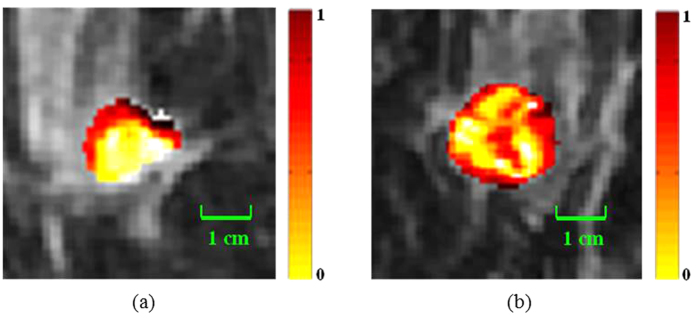
Comparison of pharmacokinetic feature (Ktrans) of estrogen receptor (ER)-positive breast lesions with low and high OncotypeDX recurrence scores.(a) Ktrans in 47-year-old women with low OncotypeDX (=8), low grade ER-positive breast lesion, and (b) Ktrans in 54-year-old women with high OncotypeDX (=58), high grade ER-positive breast lesion. The Ktrans values are encoded in a color scale, where large values are represented in dark red and small values are represented in yellow. Note a greater heterogeneity within the high risk ER-positive breast cancers compared to low risk breast cancers.